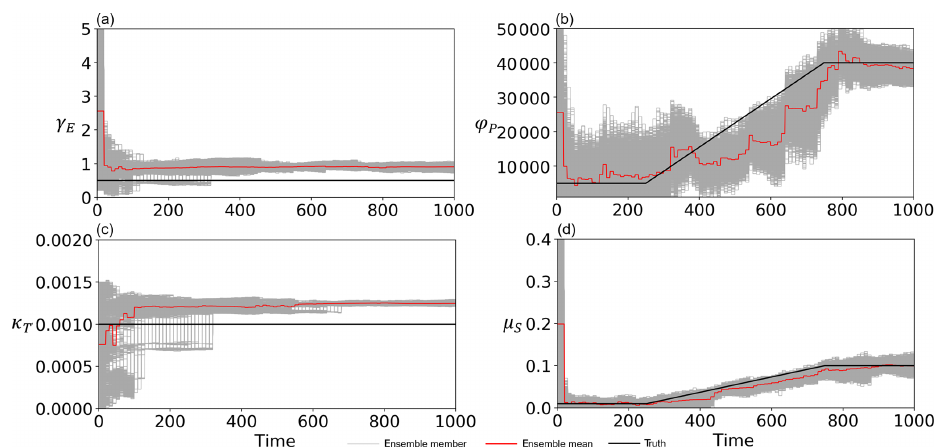
Figure 11. Time series of (a) the cost of levee raising γ E , (b) the rate at which new properties can be built ϕ P , (c) the rate of decay of levees κ T , and (d) the memory loss rate µ S estimated by the data assimilation of all observations ( F , G , D , H , and M ), with 5000 ensembles every 10 years in experiment 3 (see Sect. 3.1.3). The time step is annual. Gray, red, and black lines are the ensemble members, their mean, and the synthetic truth, respectively.